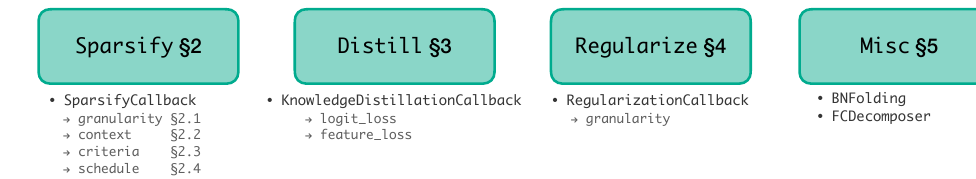
Figure 1. Illustration of the design followed by